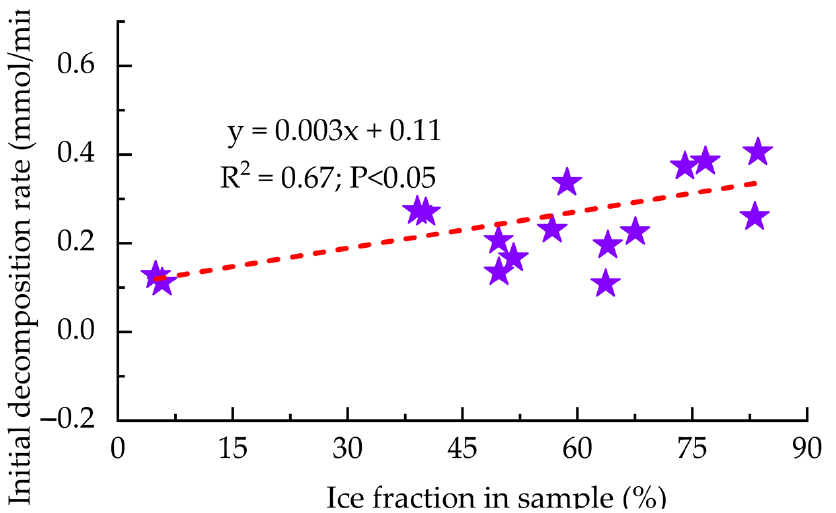
Figure 10. Relation between IDR and ice fraction in sample.